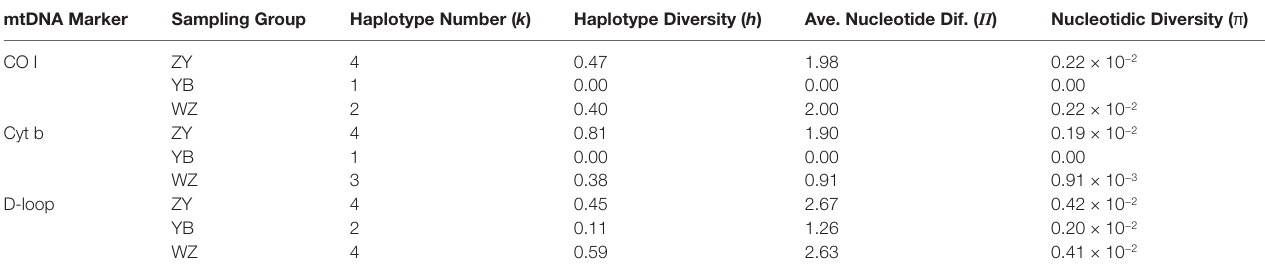
TABLE 1 | Genetic diversity indices for partial sequences of the mtDNA CO I, Cyt b, and D-loop markers in the wild population (ZY), Yibin hatchery (YB), and Wanzhou hatchery (WZ) of Procypris rabaudi. mtDNA Marker Sampling